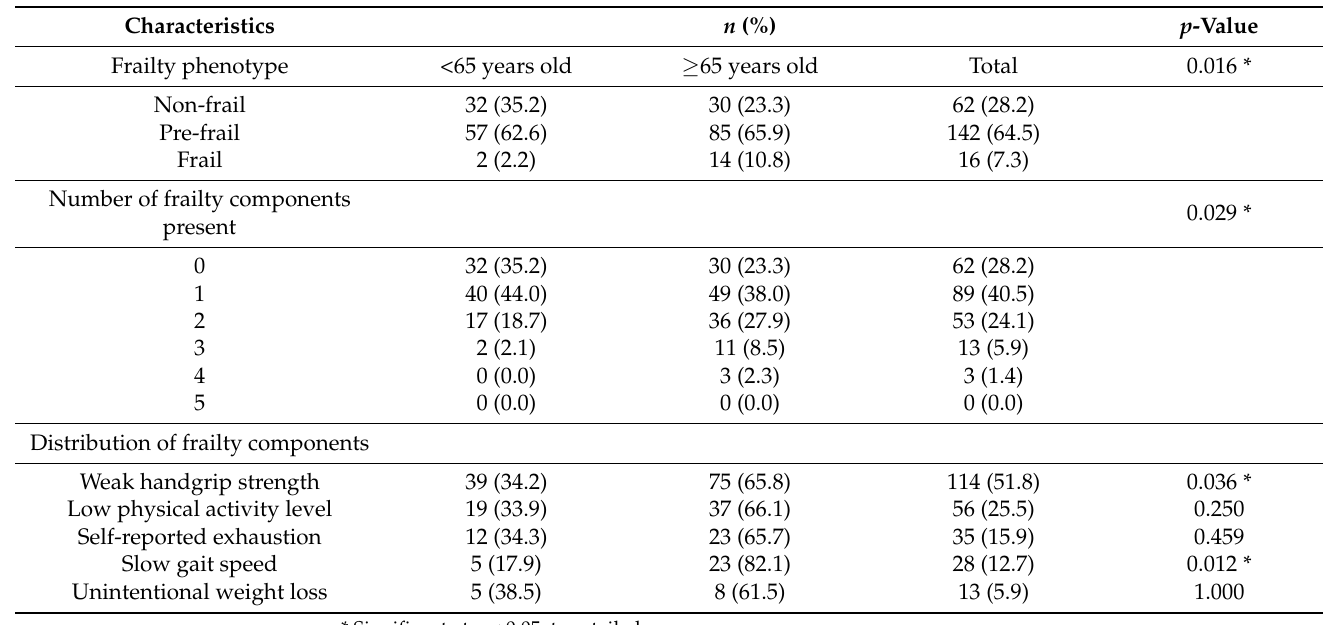
Table 1. Prevalence of frailty and its components of the respondents ( n =